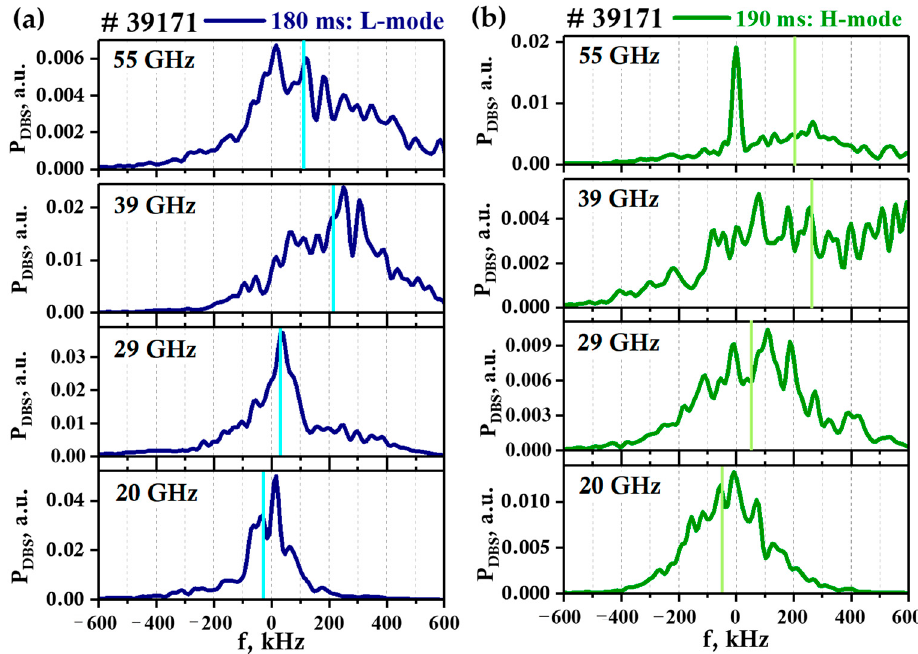
Figure 9. Spectra of DBS complex signals for discharge #39171 at: ( a ) 180 ms in L-mode; ( b ) 190 ms in H-mode.